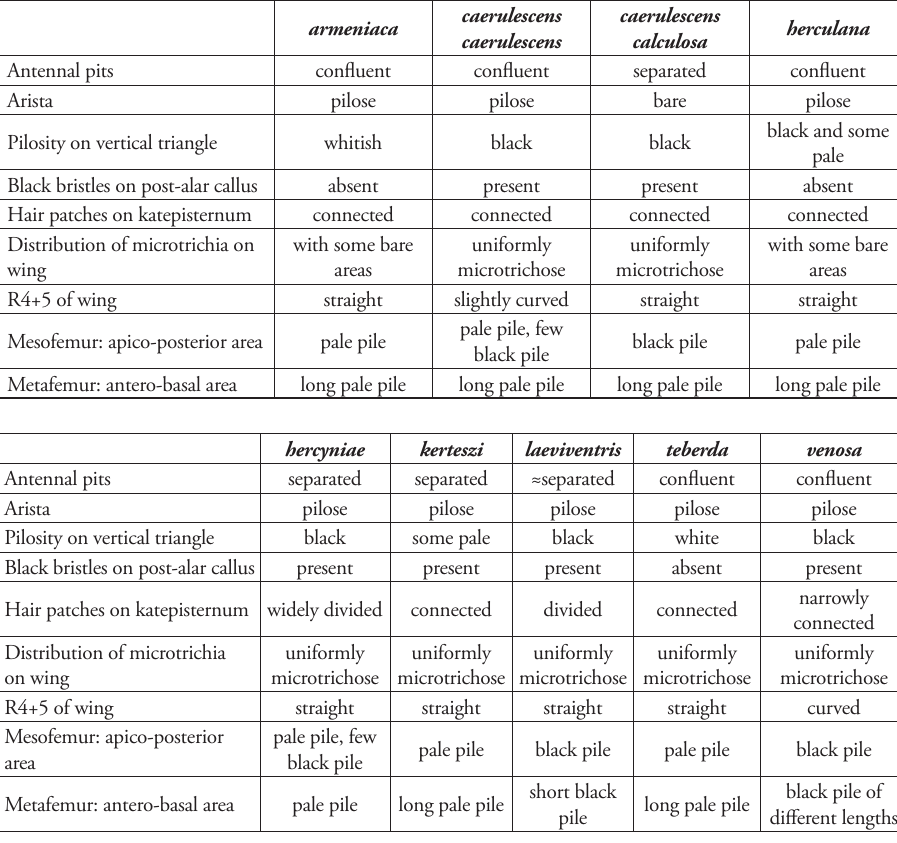
6 Abdominal tergites with erect yellow pile only ............................................ 7 – Abdominal tergites with erect to semi-erect yellow pile laterally, medially at least on tergite III with some black pile ....................................................... 8 7 Antennal pits separated, vertical triangle with black and a few yellow pile, scutum with yellow and black pile, postalar callus with few black bristles. Hypopygium as on Fig. 9E–G ................................... kerteszi Szilády, 1938 – Antennal pits confluent, all pile on body white, postalar callus without any bristles Hypopygium Fig. 6D–F .......................................... circassica sp. n. 8 Basal 1–3 segments of pro- and metatarsi dorsally yellow, arista appearing bare (Fig. 5B, C). Hypopygium Fig. 5E–G. Distribution: Russia, Lipetzk Region ... .............................................................. caerulescens calculosa Skufjin, 1977 – Basal 1–3 segments of pro- and metatarsi dorsally black or dark-brown, arista with short pile (Fig. 3C, D). Hypopygium Fig. 3E–G. Distribution: Widely distributed in Europe .................. caerulescens caerulescens (Meigen, 1822)